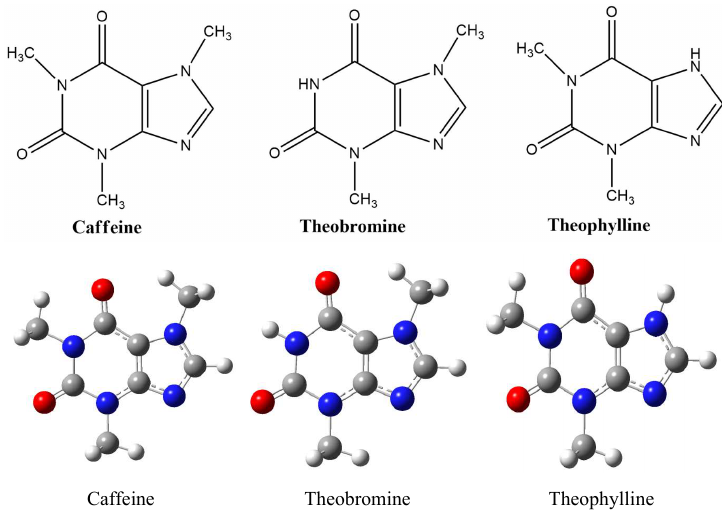
Figure 1. Optimized geometry of caffeine, theobromine, theophylline at B3LYP/6-311++G(dp) level of theory. Table 1. Structural parameters of the optimized geometry of ca ff eine, theobromine, theophylline at B3LYP / 6-311 ++ G(d,p) level of